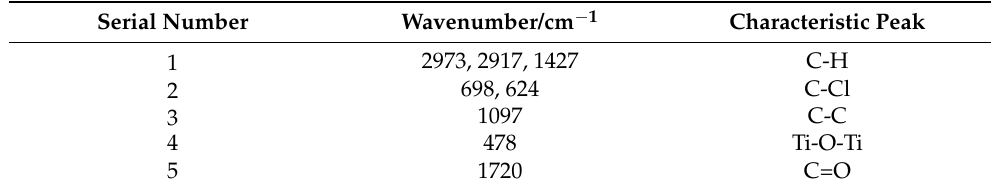
Figure 6. FT-IR spectra of polymer films. ( A ) (a) PVC before irradiation (b) PVC after irradiation, (c) TiO 2 /PVC before irradiation (d) TiO 2 /PVC after irradiation, (e) La 3+ /TiO 2 /PVC before irradiation (f) La 3+ /TiO 2 /PVC after irradiation. ( B ) La 3+ /TiO 2 /PVC after irradiation for 0 h, 10 h, 20 h, 30 h. Table 1. The characteristic peak of infrared spectrum structure. Table 1. The characteristic peak of infrared spectrum structure.